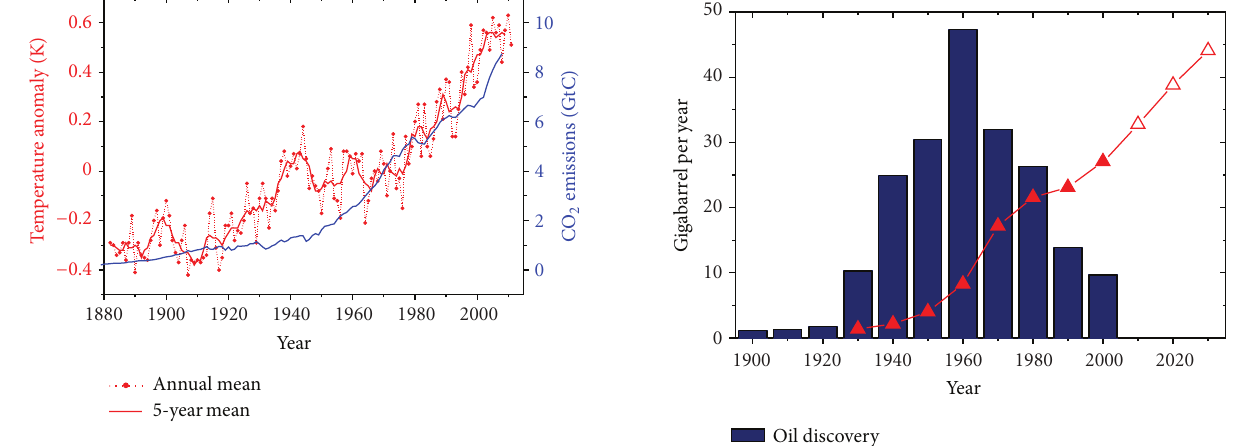
Figure 1: Global temperature (red) and CO 2 emissions (blue) over the past decades [14–16].